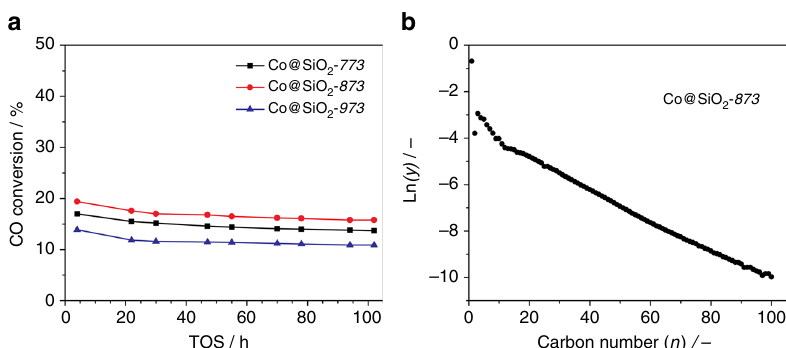
Fig. 4 Catalytic performance. a Time-on-stream evolution of CO conversion for the Co@SiO 2 catalysts. b Molar fraction distribution of FTS products from Co@SiO 2 - 873 after 201 h on stream. Chain growth probability ( α = 0.94) obtained from the ASF plot in the C15-C100 hydrocarbon range. Reaction conditions: 483 K, 20 bar, and H 2 /CO = 1, and syngas fl ow of 40 ml min − 1